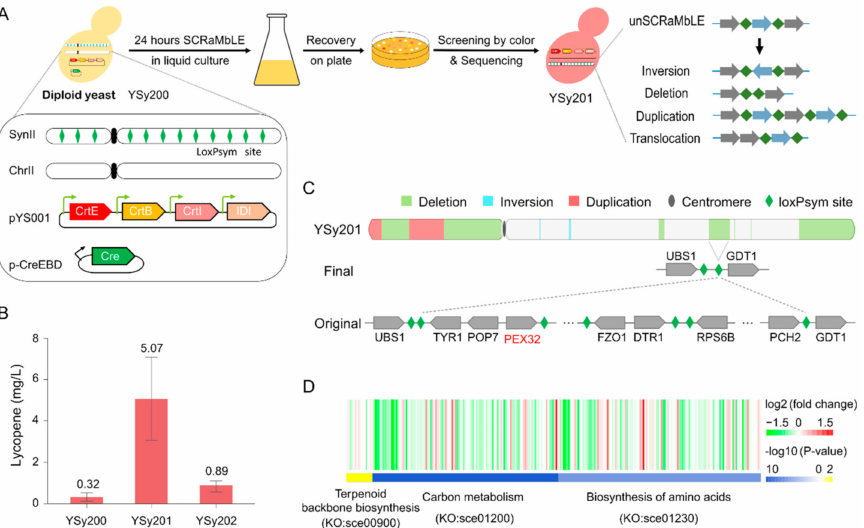
Figure 1. Host strain improvement by Synthetic Chromosome Rearrangement and Modifica- tion by LoxP-mediated Evolution (SCRaMbLE) of diploid yeast bearing synthetic chromosome. ( A ). Schematic illustration of host optimization by SCRaMbLE for improving lycopene production in S. cerevisiae . ( B ). The lycopene production in strain YSy200 (unSCRaMbLEd), YSy201(SCRaMbLEd) and YSy202 (YSy200 pex32 ∆ 0 /PEX32) were assessed by HPLC. Error bars indicate ± SD (n = 3). ( C ). The structure variations created by SCRaMbLE in strain YSy201. ( D ). Three key pathways (KO:sce00900, KO:sce01200 and KO:sce01230) display transcriptional changes in strain